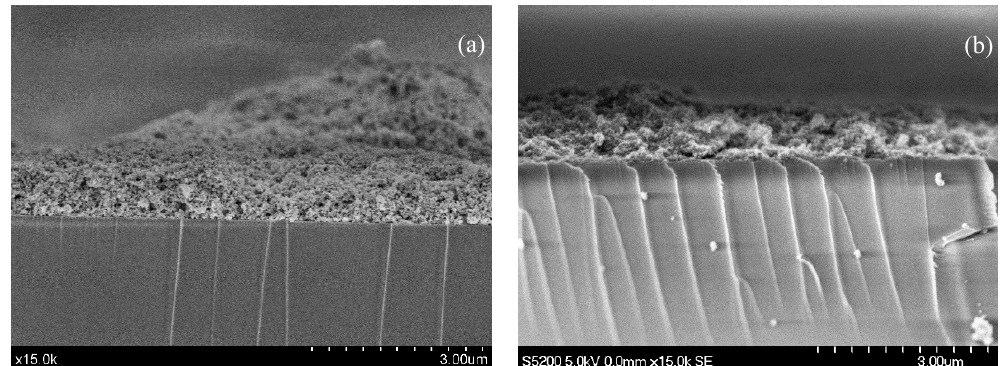
Figure 5. Deposit of 1.16 mg · cm − 2 of Pd-P ( a ) and Pd-I ( b ).